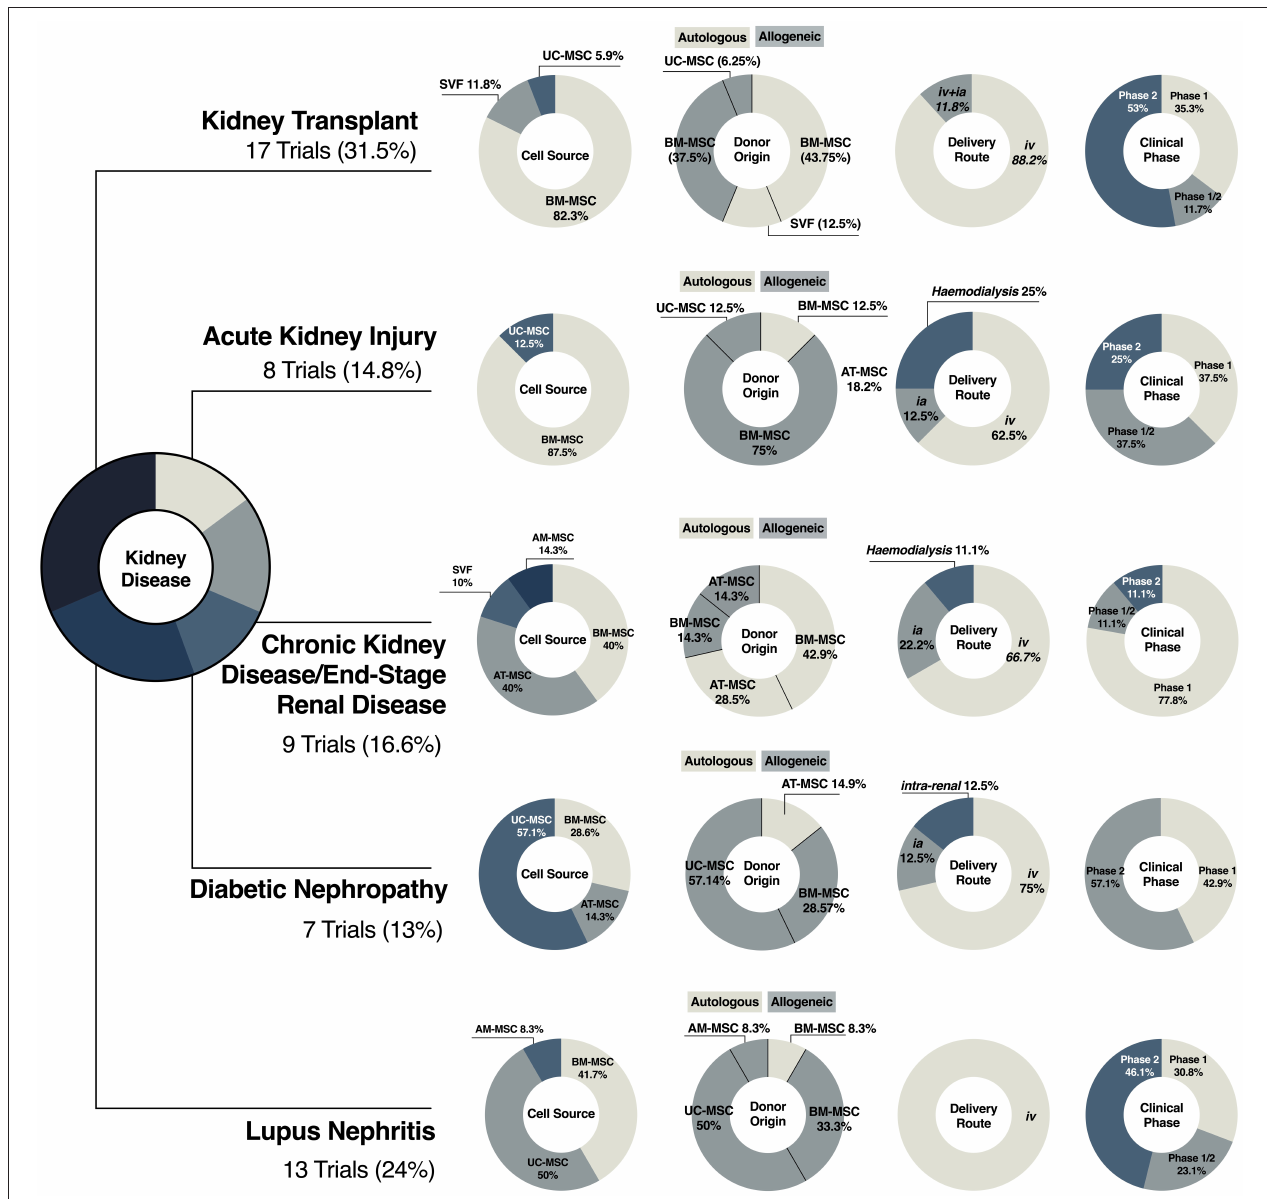
FIGURE 4 | Clinical translation of MSC therapies in kidney disease. Illustrative representation of the diversification of MSC-based products in clinical trials of kidney transplantation, acute kidney injury, chronic kidney disease, diabetic nephropathy and lupus nephritis, including cell source and donor origin, and clinical variables, such as delivery route and clinical phase